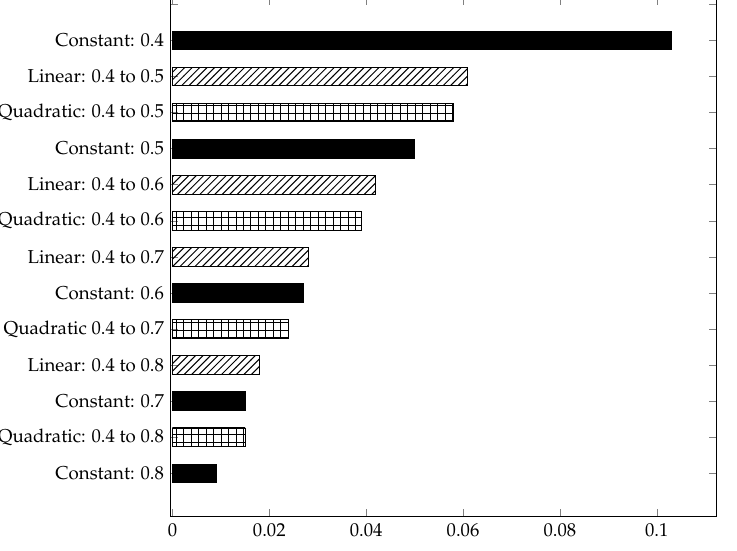
Figure 8. Dimensionless, scaled effective Young modules ¯ E of gyroid structures in decreasing